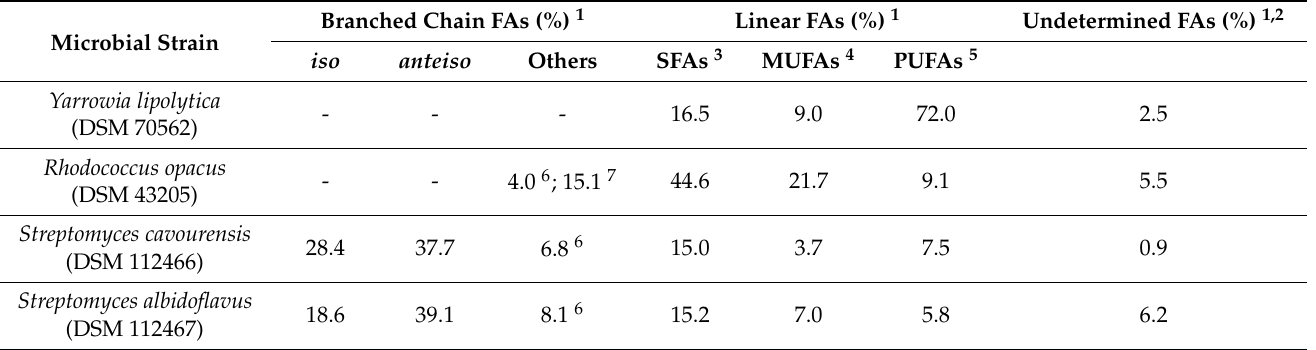
Table 2. Fatty acid composition of the glycerides produced by the selected microbial strains grown in BSG